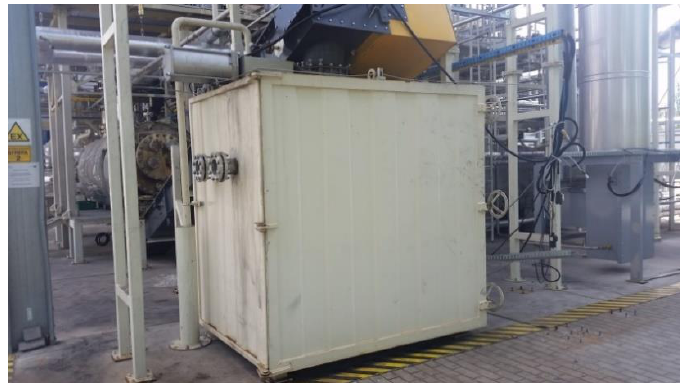
Figure 5. Photo of the final part of the process line for the removal of contaminants from reactor R101 The K201 container with the PK201 feeder can be seen in the foreground.